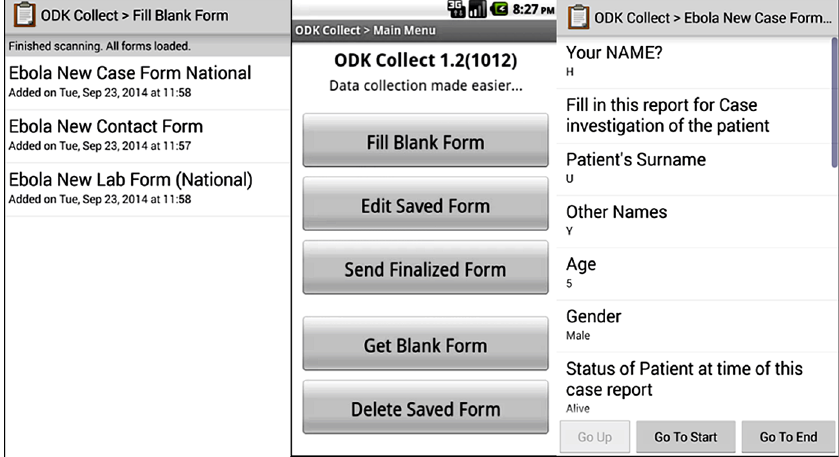
Fig 1. Screen shot of ODK collect App on mobile phones and ehealth follow up Ebola sense.